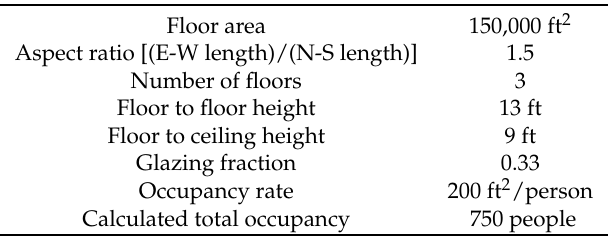
Table A2. DOE reference model for a “Medium Office